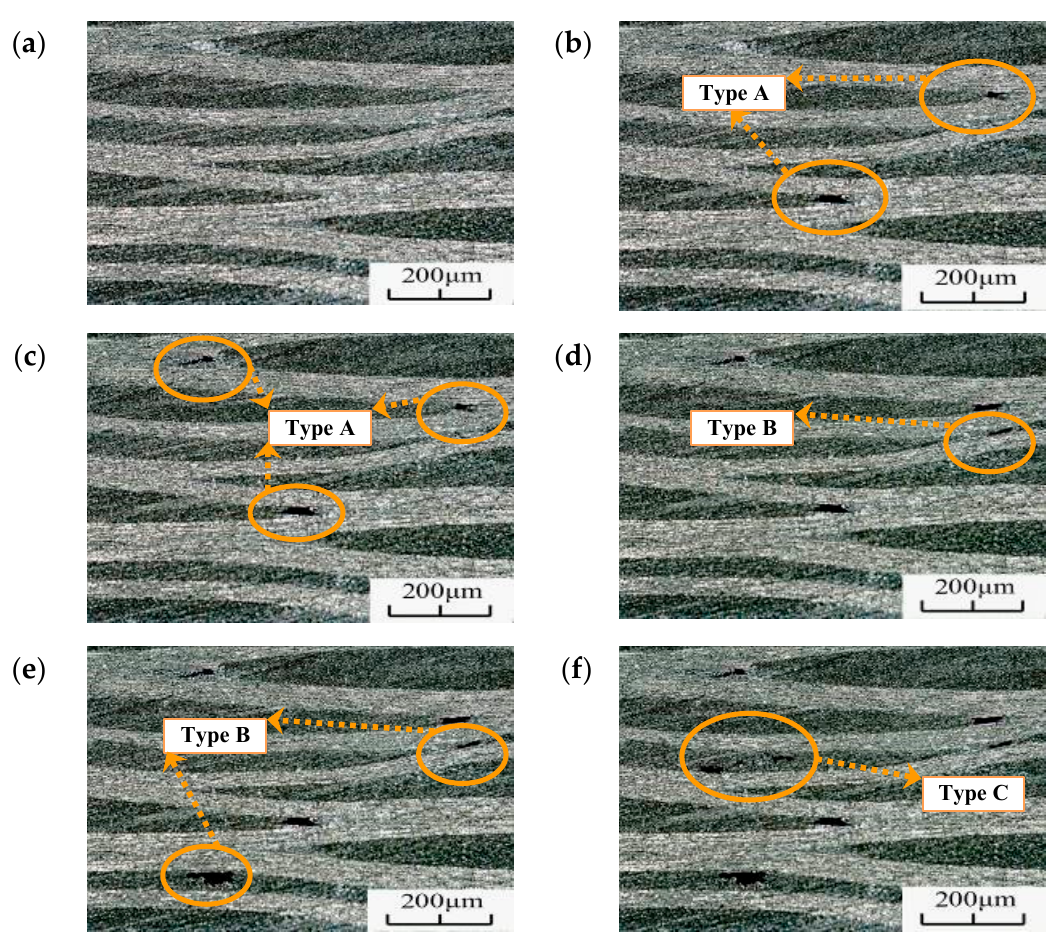
Figure 13. Fatigue failure morphology after different weeks for the same field of view (R = 0.35, σ max = 368 MPa) for ( a ) N = 0, ( b ) N = 7.6 × 10 7 , ( c ) N = 1.45 × 10 8 , ( d ) N = 6.23 × 10 8 , ( e ) N = 8.86 × 10 8 , and ( f ) N = 2.17 × 10 9 .